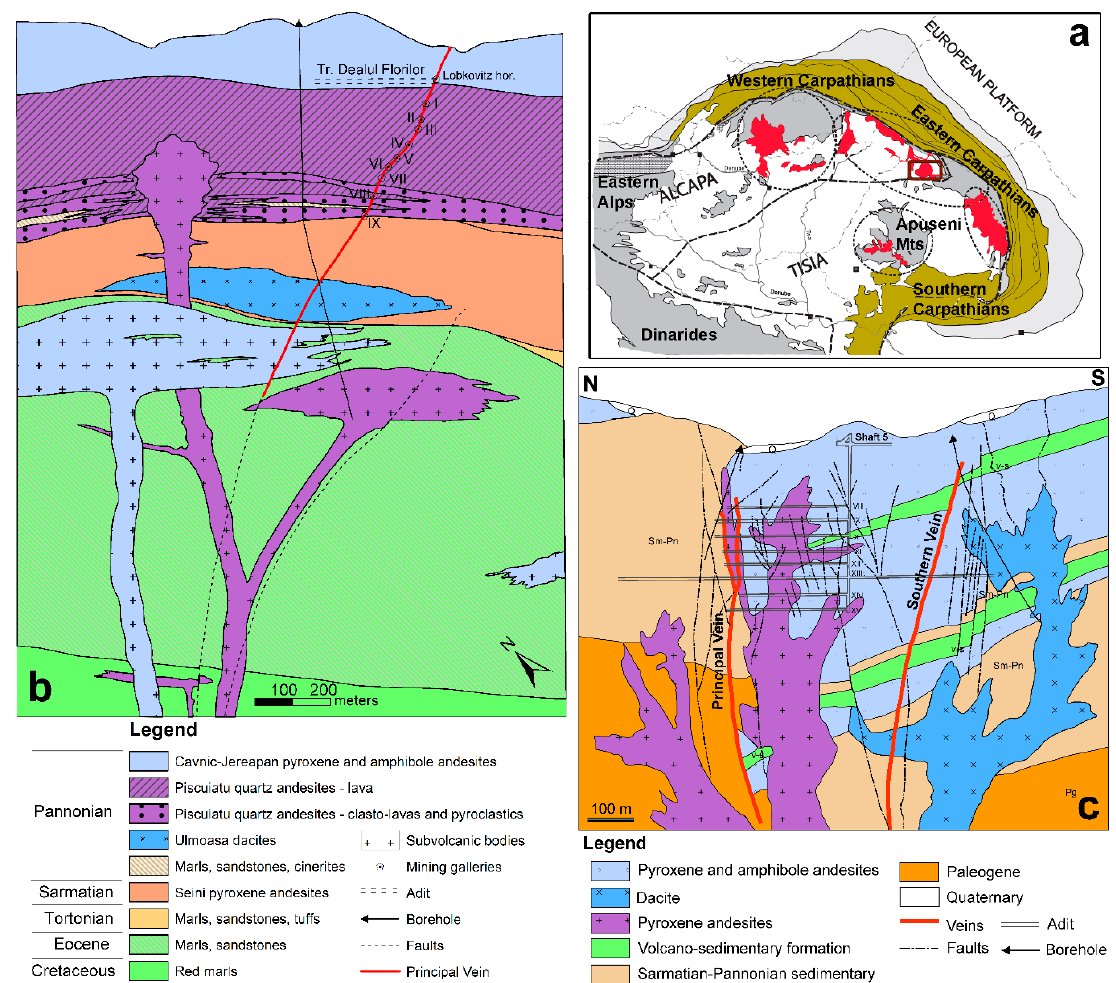
Figure 2. ( a ) Samplified Carpathian–Pannonian region map with the location of BaiaMare district [23]; ( b ) geological cross-section of Dealul Crucii [25]; ( c ) geological cross-section of Baia Sprie deposit eastern part [26].